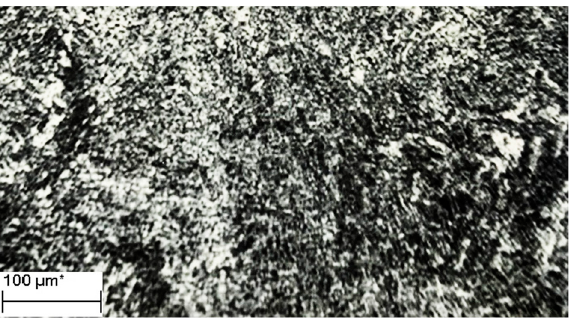
Figure 12. The structure of the area of incomplete recrystallization, template 2 (see Figure 7). ×400. *—mkm.